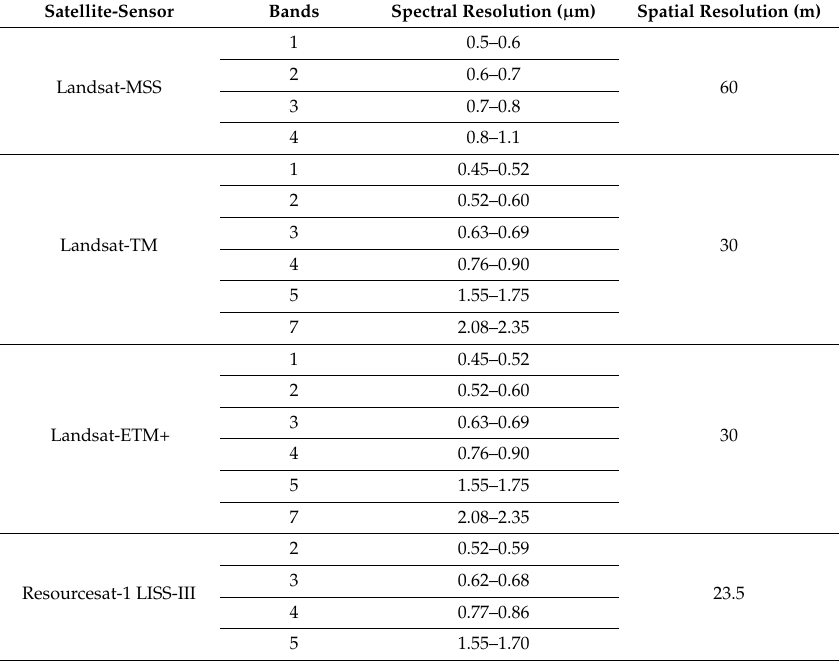
Table A1. Details of the Spectral and Spatial resolutions of the Satellite Imagery